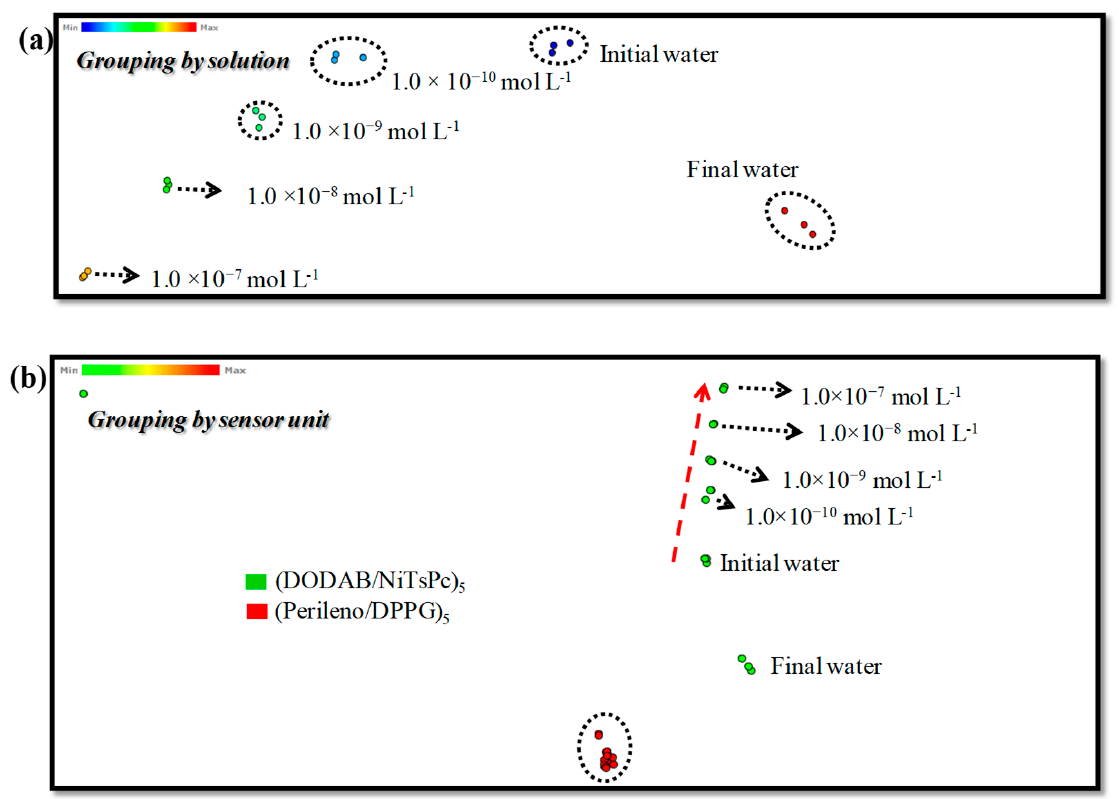
Figure 3. IDMAP projection from capacitance data ( a ) of all sensing units combined, grouping by solution. ( b ) IDMAP projection grouping by sensing unit. IDE 10.